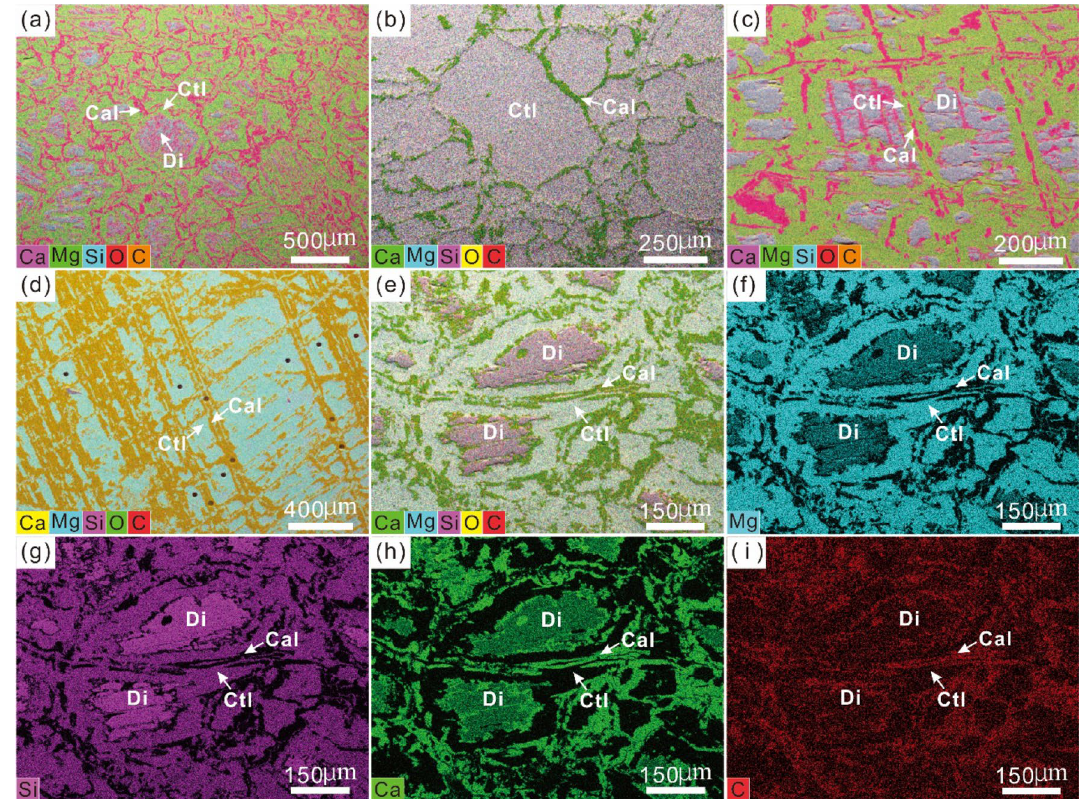
Figure 5. Composite element map images of serpentinized diopsidite in the Yushishan area. Composite element images are made by combining carbon (C) images with superimposed Mg, Ca, O, and Si images. ( a ) Serpentinization proceeded along the grain boundaries of diopsides. ( b ) Complete serpentinization of diopside forming pseudomorphs of chrysotile + calcite, without cleavage. ( c ) Serpentinization proceeded along the cleavages of diopsides. ( d ) Complete serpentinization of diopside forming pseudomorphs of chrysotile + calcite with cleavages. ( e–i ) Composite element image and Mg, Si, Ca, and C